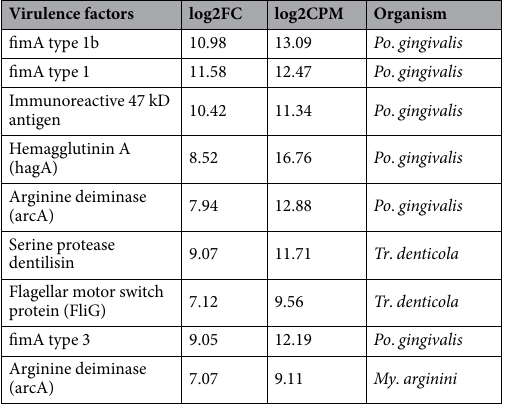
Table 2. Differentially expressed virulence factors in health and periodontitis. Reads were mapped against MvirDB to investigate the expression level of virulence factors. The table lists the differentially expressed virulence factor genes calculated by